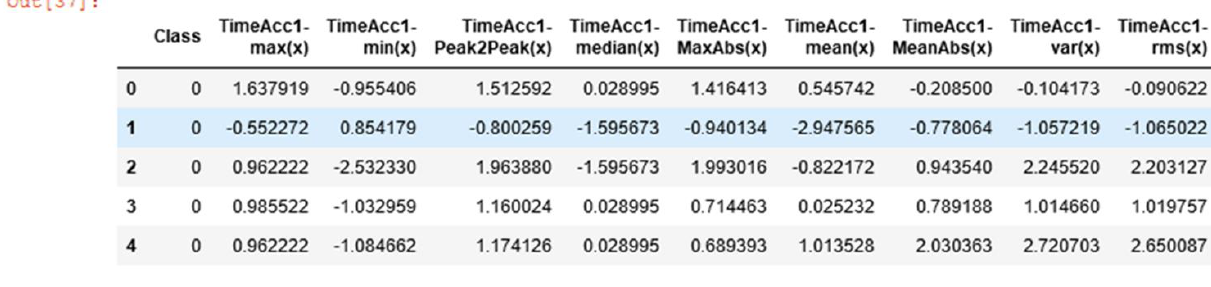
Figure 1. Loading and presenting data in Jupyter software.